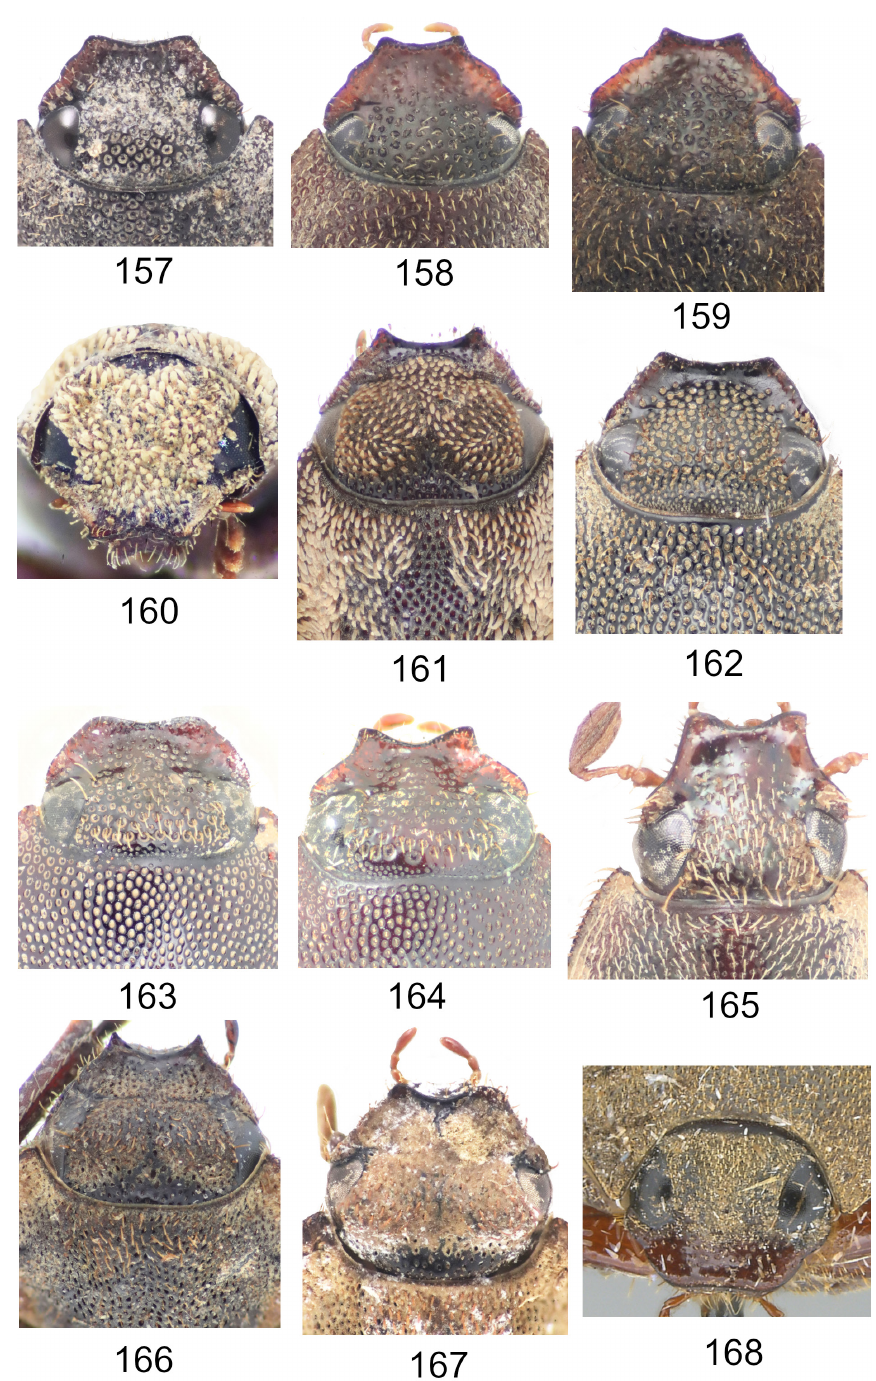
Figs 157–168. Papuan and Wallacean Maechidius Macleay, 1819, head, dorsal (157–159, 161–167) and frontal (160, 168) views. 157 . M. parallelicollis Moser, 1920, lectotype, ♂ (ZMHB). 158 . M. paupianus Heller, 1910, lectotype, ♀ (SNSD). 159 . Same, ♂ (paratype of M. arrowi Frey, 1969) (BMNH). 160 . M. pauxillus Heller, 1910 comb. rest., lectotype, ♂ (SNSD). 161 . Same, ♀ (SNSD). 162 . M. peregrinus Lansberge, 1886, ♂ (DTC). 163 . M. pedarioides Arrow, 1941, syntype, ♀ (BMNH). 164 . Same, syntype, ♂ (BMNH). 165 . M. riedeli sp. nov., holotype, ♂ (SMNS). 166 . M. perlatus (Frey, 1969) comb. nov., holotype, ♂ (NHMB). 167 . Same, ♀ (NHMB). 168 . M. simplex Frey, 1969, holotype, ♂ (photograph courtesy BPBM) (BPBM). Not to